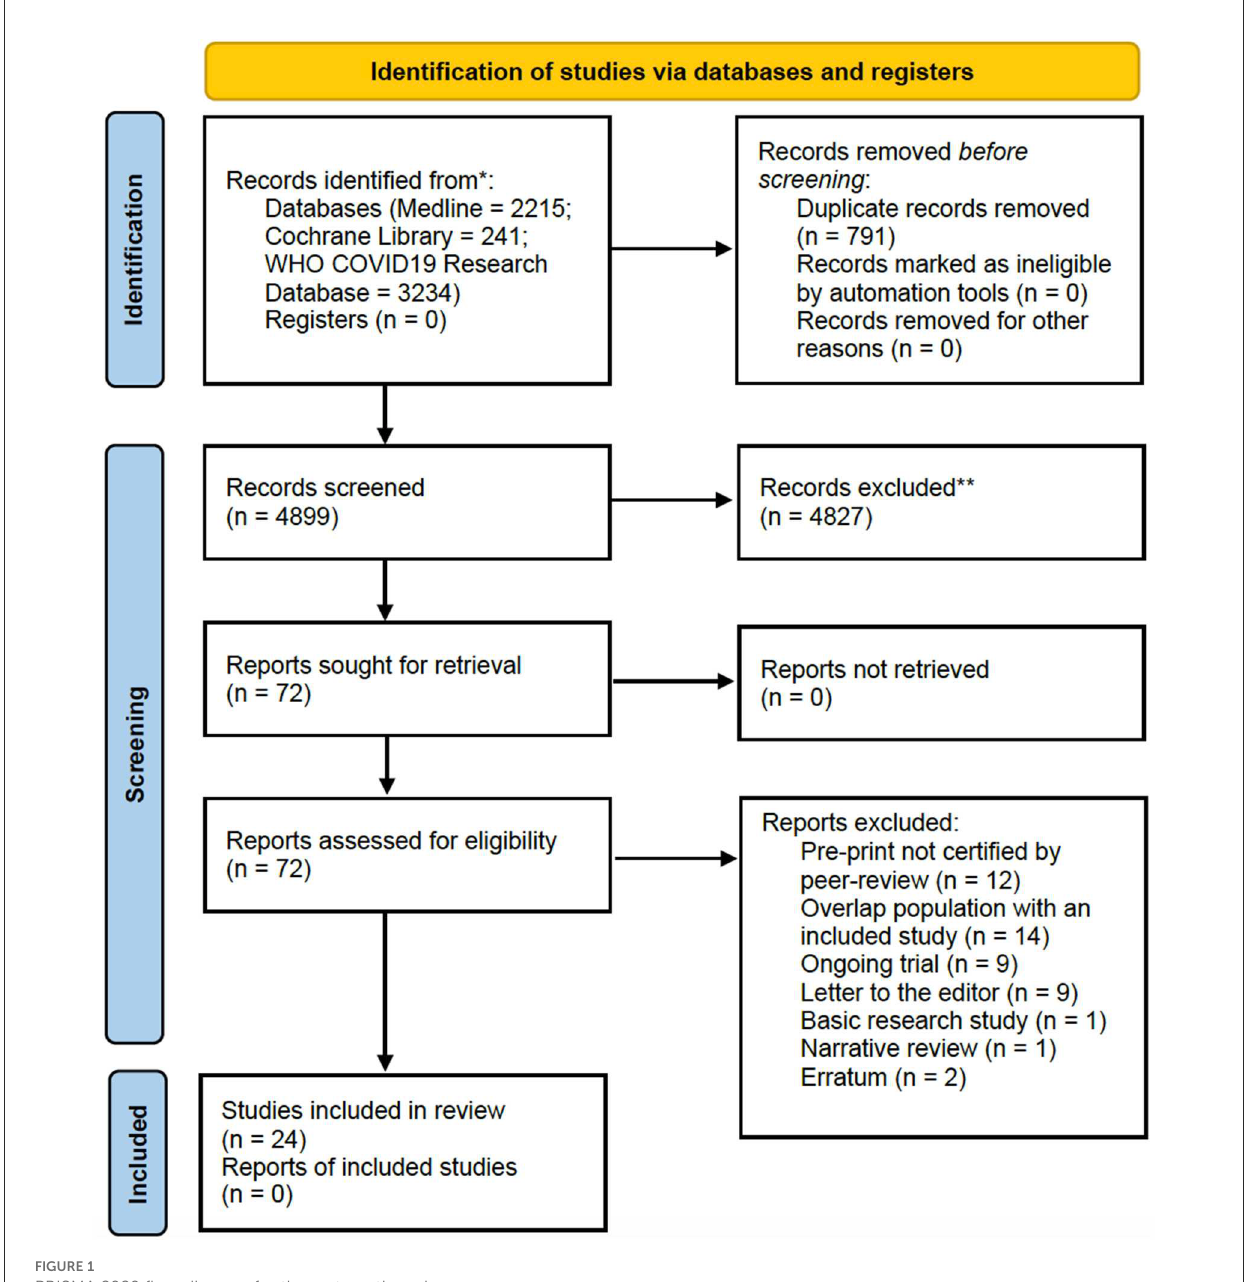
FIGURE1 PRISMA 2020 flow diagram for the systematic review.